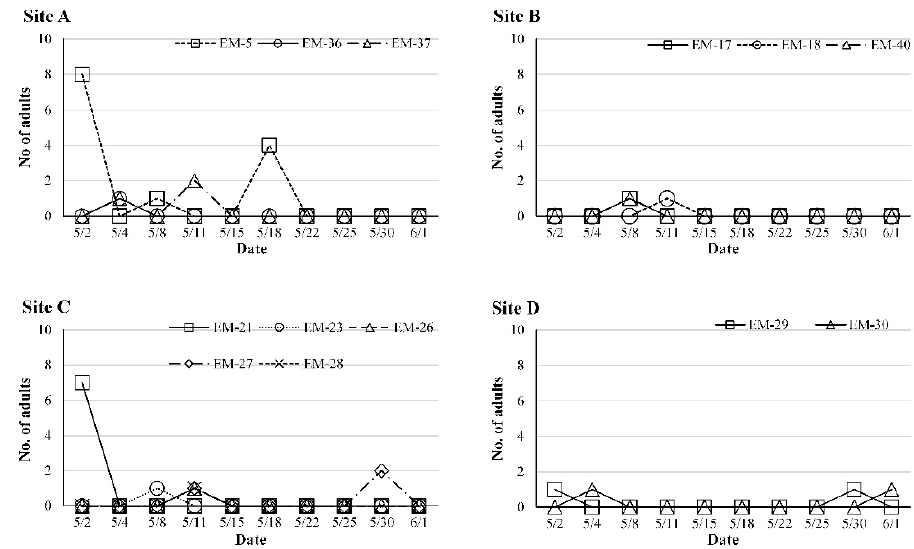
Figure 3. Seasonal abundance of O. kuvanae by egg mass on different oviposition sites based on field observation of L. delicatula eggs in